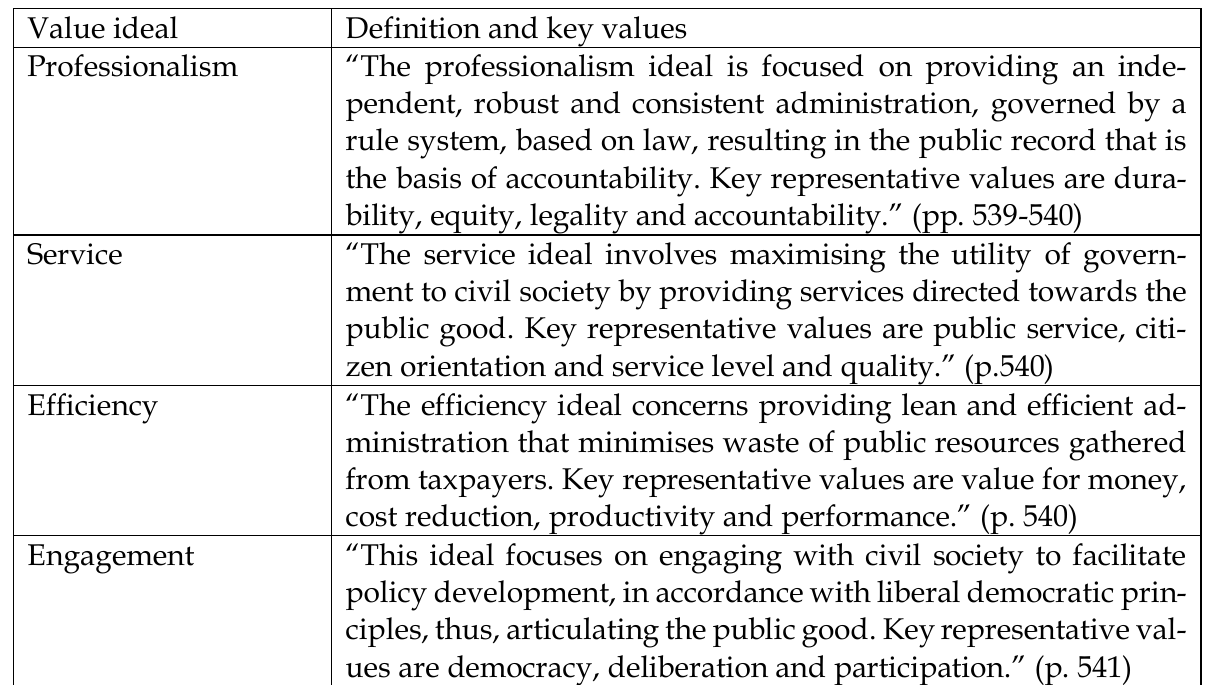
Table 2. Model of value ideals, adapted from Rose et al.